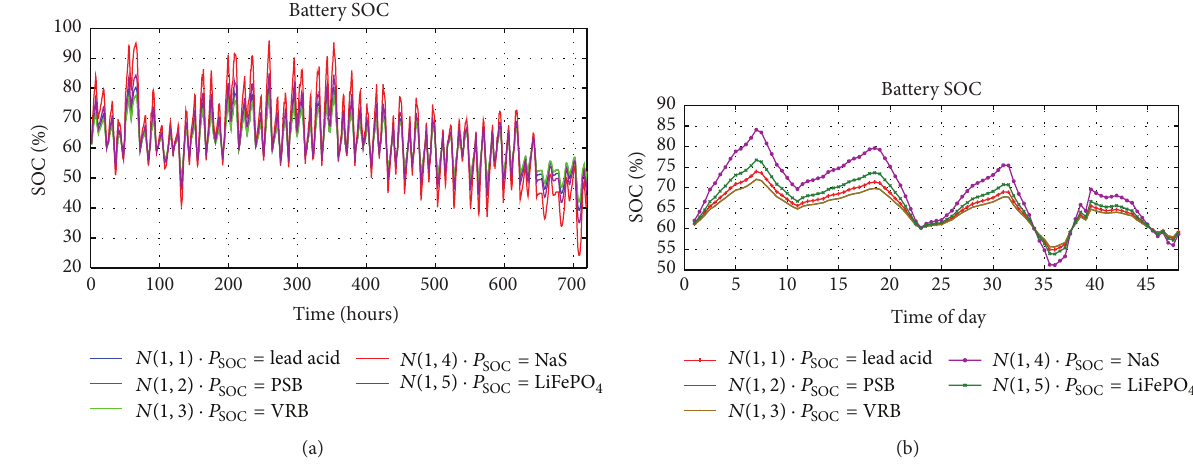
Figure 12: (a) SOC of batteries. (b) SOC of batteries for 48hrs. Table 8: Economic analysis without optimization.